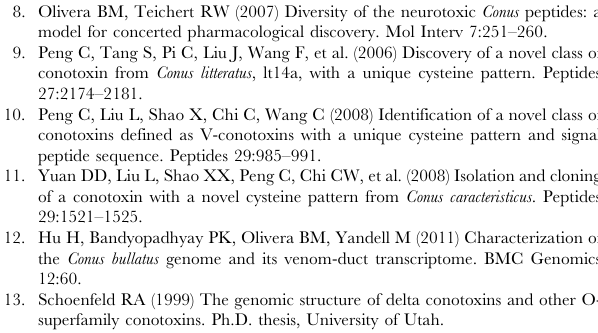
Figure S1 Sequence alignment of the two introns of 13 conotoxins from nine superfamilies. The intron sequence of A-conotoxin Vr1.2 was selected to algin with each intron sequence of the other eight superfamilies. Only the first and last 80 bp of these sequences are shown. Figure S2 Sequence alignment of 16 introns of the A superfamily. For the conotoxins that contained the same coding regions, only the longest region has been aligned. Only the first and last 80 bp of these sequences are shown. Table S1 Predicted sequences of all A superfamily conotoxins cloned in this paper. Table S2 The Percent Identity Matrix of the A super- family intron sequences. Table S3 Dn (top) and Ds (bottom) values of the signal peptide region, propeptide region and mature peptide region within six conotoxin